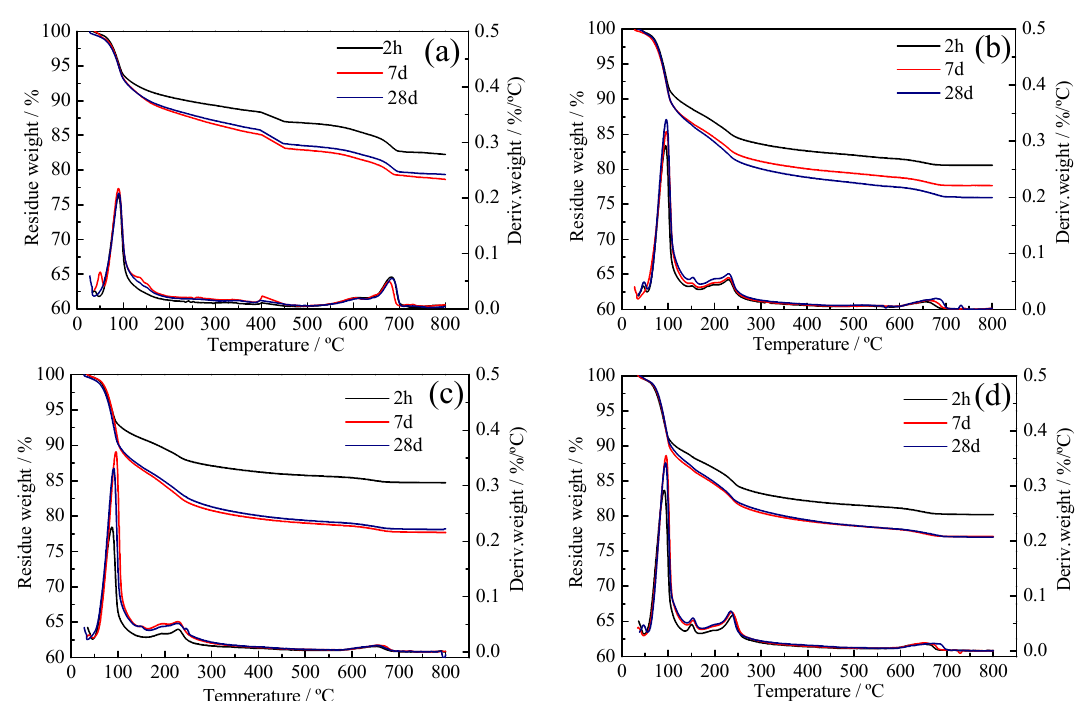
Figure 5. TG curves of CSA pastes with superplasticizers for 2 h, 7 d, 28 d ( a ) BNS-0.8%, ( b ) BNS-2.0%, ( c ) PC-0.08%, ( d ) PC-0.20%.